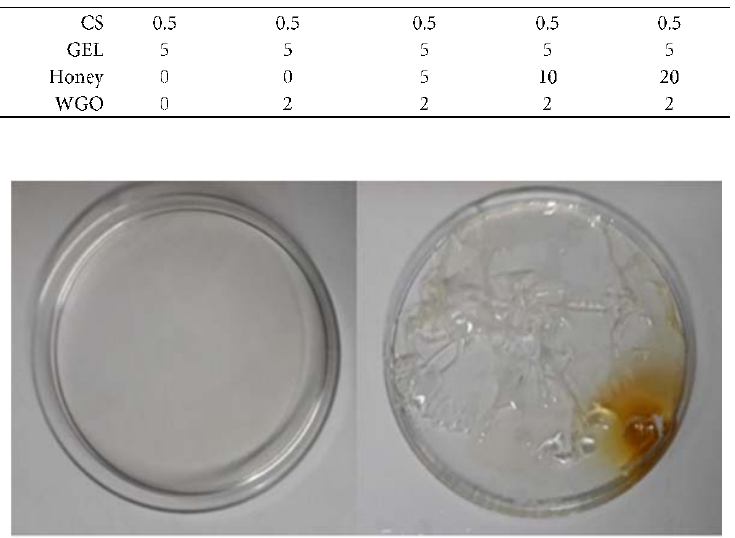
Fig. 1. Photographic appearance of CS/GEL thin film Figure 1 . Photographic appearance of CS/GEL thin film